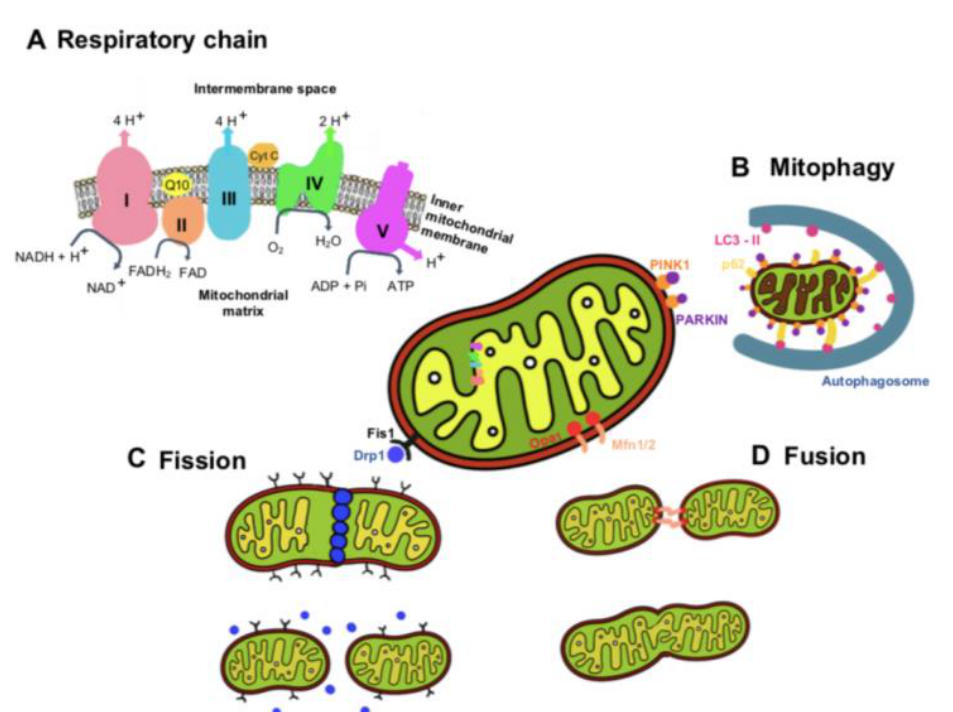
Figure 1. Respiratory chain and mitochondrial dynamics. ( A ) Respiratory chain. Electrons and protons flow through complexes of the respiratory chain in oxidative phosphorylation. ( B ) Mitophagy is mediated by PINK1, PARKIN, and P-62 proteins, which recruit the protein LC3-II and form the au- tophagosome for cell degradation. ( C ) Mitochondrial fission is mediated by the protein Drp1, which is recruited from the cytosol to interact with the protein fis1 in the mitochondrial outer membrane, form- ing constriction points that lead to mitochondrial fission. ( D ) Mitochondrial fusion requires the action of the Opa1 protein on the inner mitochondrial membrane and the action of Mfn1 and Mfn2 proteins in the outer mitochondrial membrane, promoting the fusion of juxtaposed mitochondrial